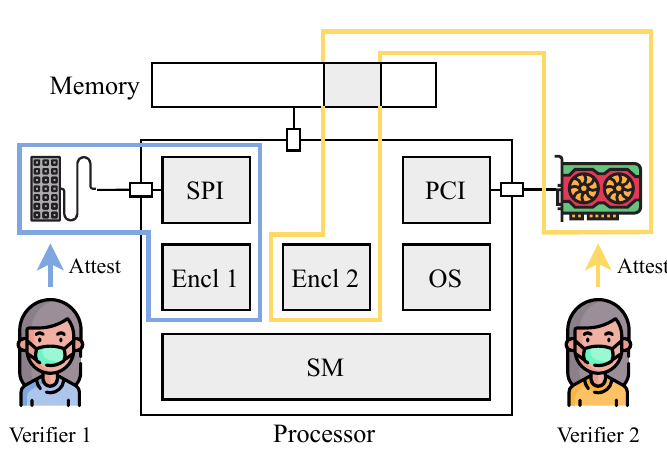
Figure 1: Two composite enclaves are highlighted by blue and yellow outlines. Both consist of two unit enclaves: Encl1 and the keyboard that is connected over the memory-mapped SPI bus, and Encl2 and a GPU connected over PCI through